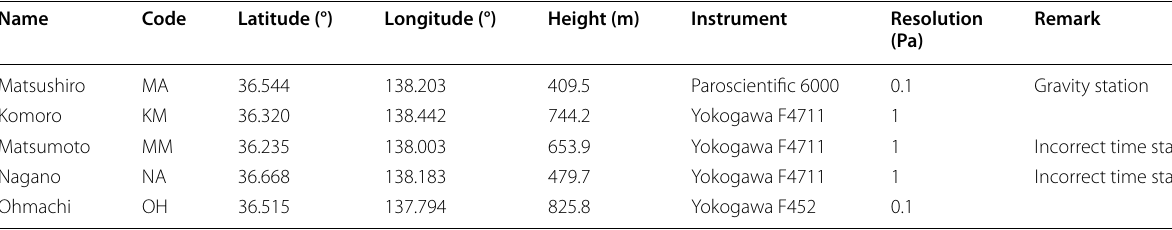
Table 1 Barometer stations around Matsushiro,